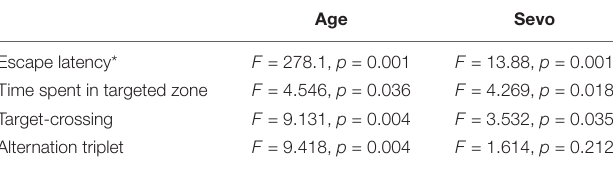
TABLE 3 | Two-way ANOVA analysis of cognitive function in adult and aged mice.